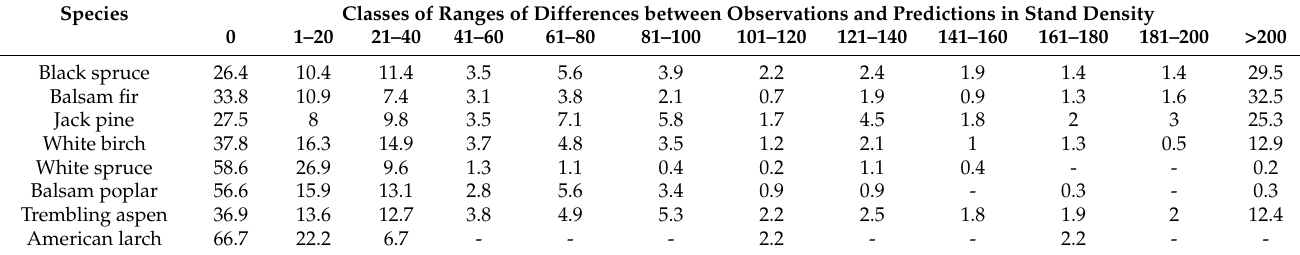
Table 9. Percentages of plots in different classes (20 trees ha − 1 ) of differences between observed and predicted stand densities (trees ha − 1 ) in Ecoregion 3W in northern Ontario, Canada. Species Classes of Ranges of Differences between Observations and Predictions in Stand Density 0 Black